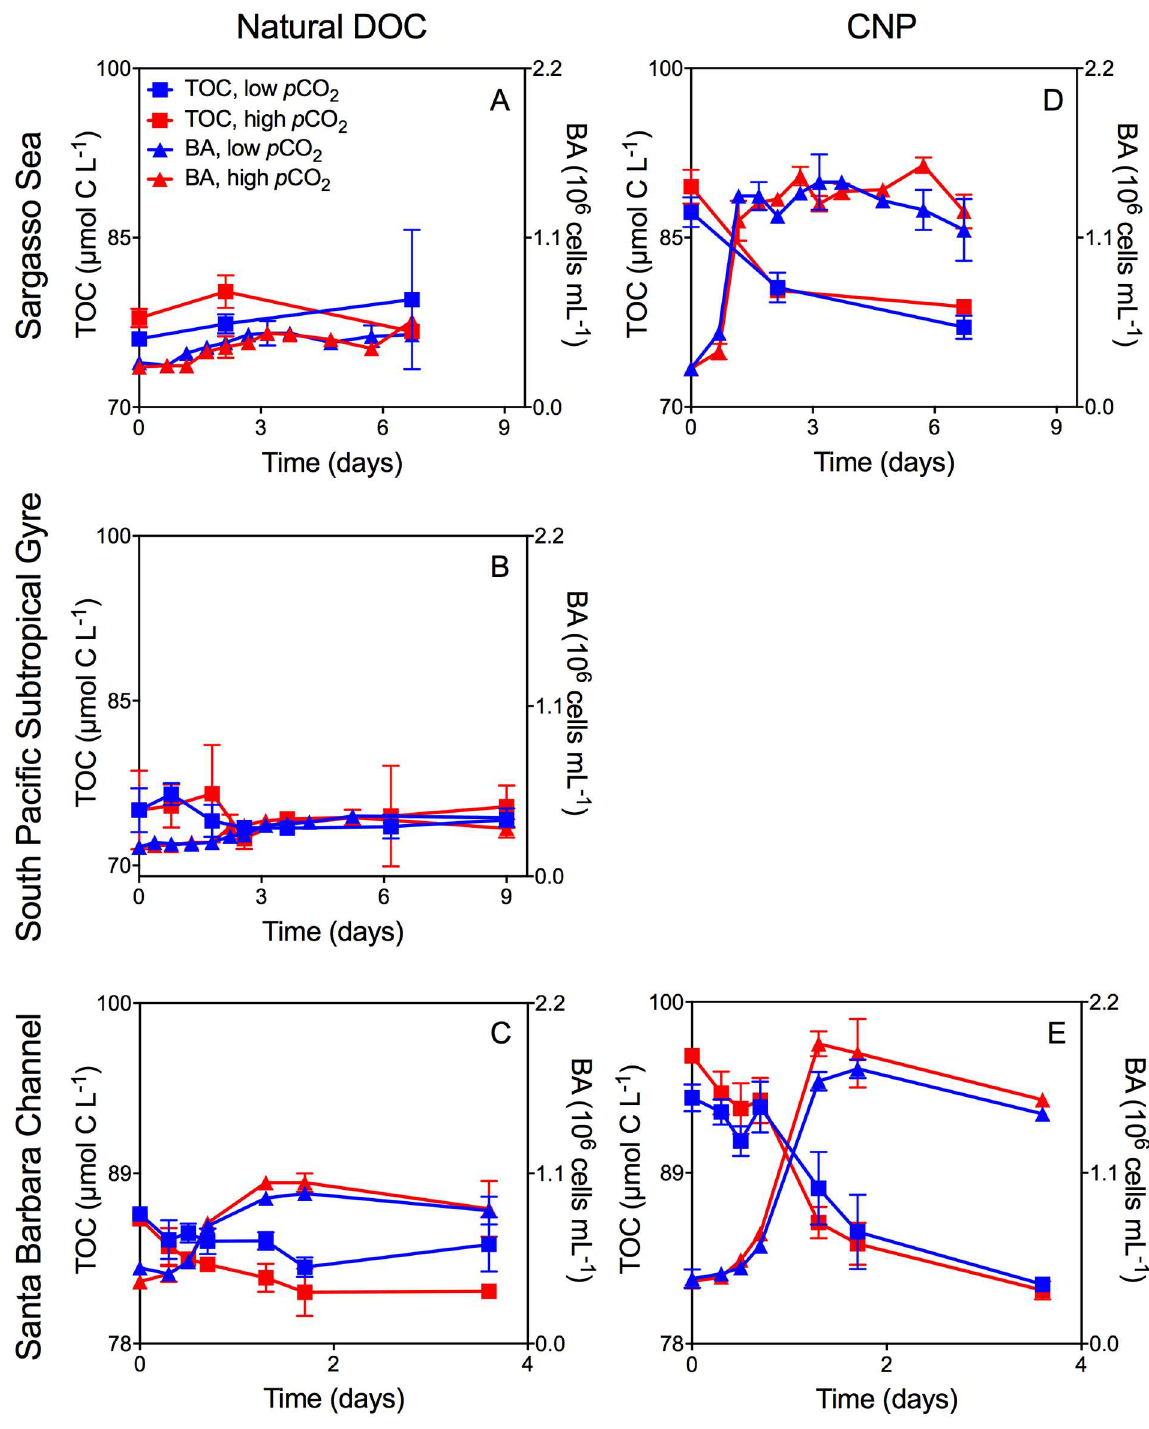
Fig 1. Mean TOC concentration and mean bacterioplankton abundance for Sargasso Sea and Santa BarbaraChannel CNP- and natural-DOC experiments. Mean TOC concentration ( ± SD) and mean bacterioplankton abundance (BA; ± SD) averaged across duplicateincubations through time and as a function of p CO 2 for natural bacterioplankton assemblagesincubatedwith: A: Natural DOC, Sargasso Sea Exp. #1A; B: Natural DOC, South Pacific SubtropicalGyre Exp. #7; C: Natural DOC, Santa Barbara ChannelExp. #2A; D. CNP, Sargasso Sea Exp. #1B; E. CNP, Santa BarbaraChannelExp. #2B. For treatments at all sites, red denotes elevated p CO 2, while blue denotesambient p CO 2 in the Sargasso Sea experiment and pre-industrial p CO 2 in the Santa Barbara Channeland South Pacific SubtropicalGyre experiments. Squares represent TOC ( μ mol C L -1 ) whiletrianglesdenoteBA (10 6 cells mL -1 ) over the course of the incubation.